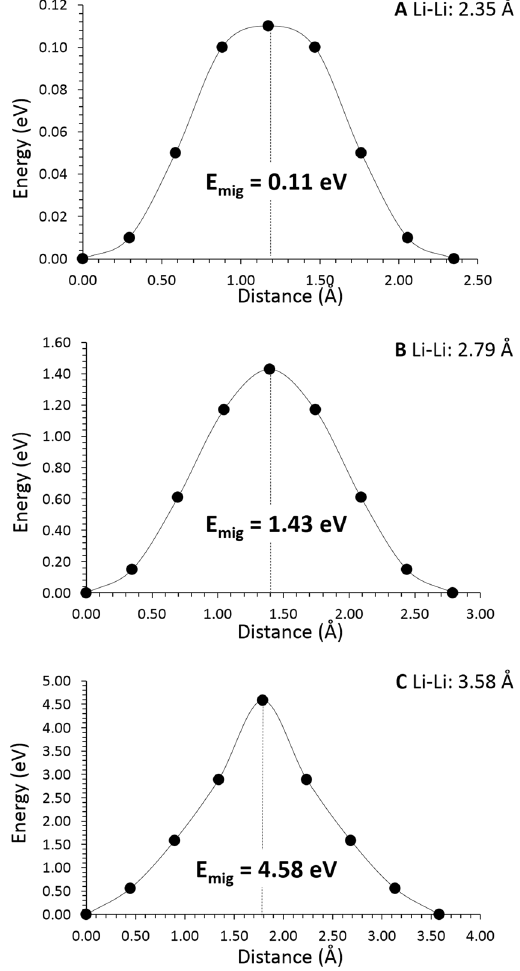
Figure 2. Three different energy profiles [as shown in Fig. 2 for Li diffusion paths (A, B and C)] of Li vacancy hopping between two adjacent Li sites in Li 2 CuO 2 . E mig corresponds to the activation energy for the Li ion